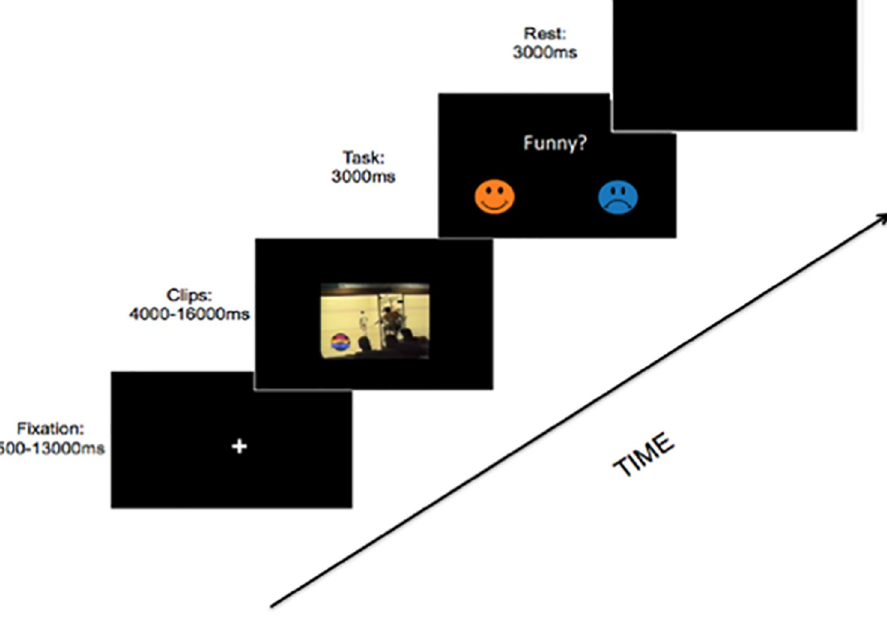
Fig 1. Experimental timeline. Participants viewed short humorous or neutral video clips (4000–16,000 ms) and were given 3000 ms following the clip to indicate with a button press whether they liked or did not like the video clip. Intertrial interval ranged from 500 to 13,000